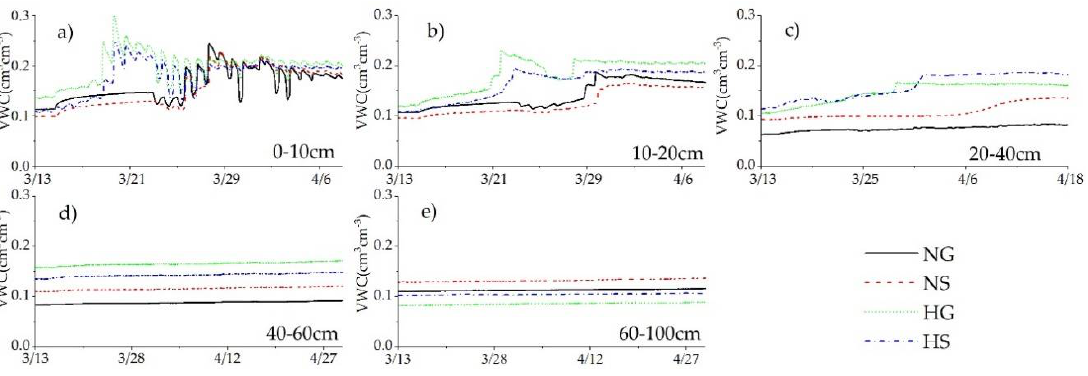
Figure 5. The VWC variance in early spring (2016) for all sites from 0–100 cm. ( a ) VWC dynamics at 0–10 cm; ( b ) VWC dynamics at 10–20 cm; ( c ) VWC dynamics at 20–40 cm; ( d ) VWC dynamics at 40–60 cm; ( e ) VWC dynamics at 60–100 cm.